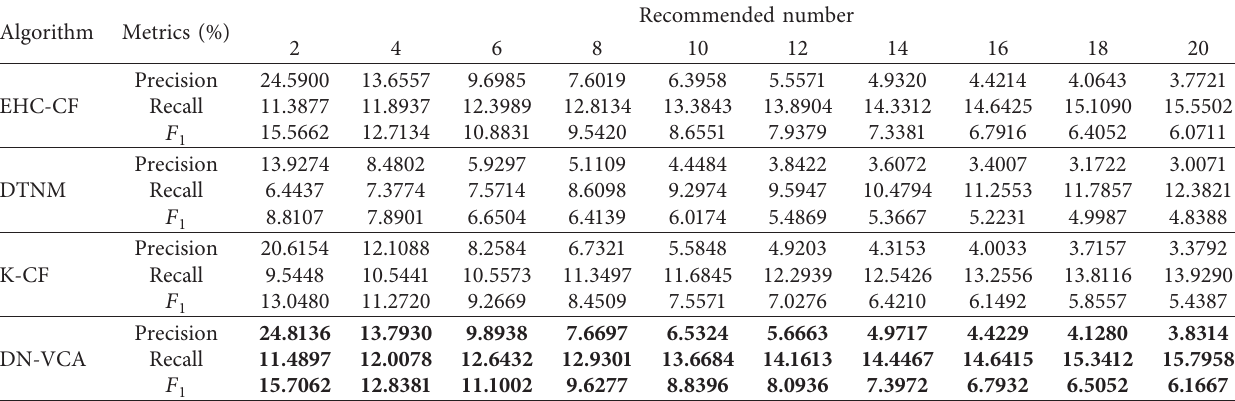
of EHC-CF, DTNM, K-CF, and DN-VCA based on CiaoDVD-1 dataset. 1